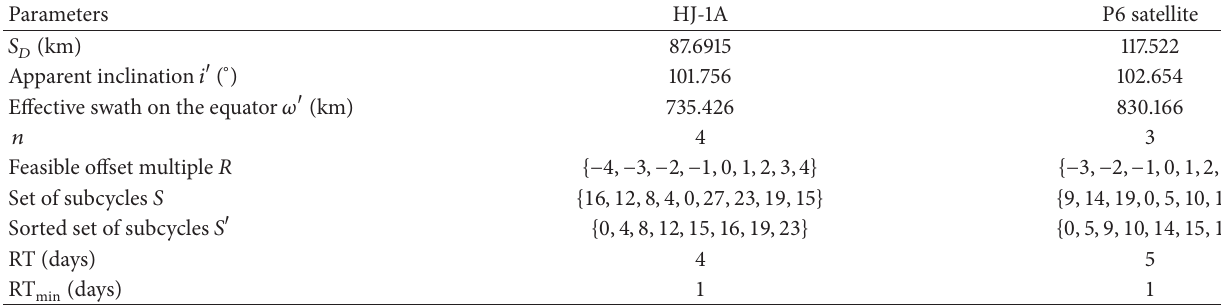
Table 5: The revisit time of two satellites.